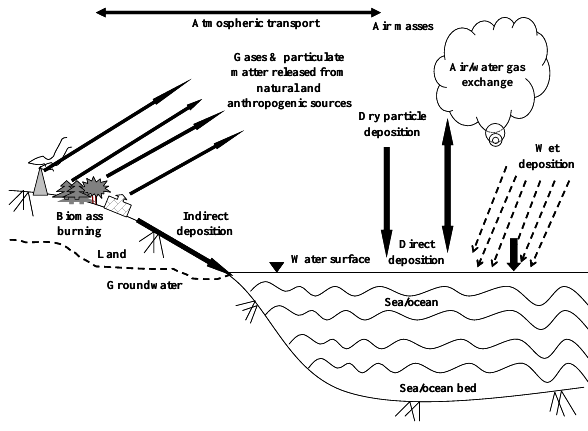
Fig. 1. A schematic illustration of atmospheric deposition processes